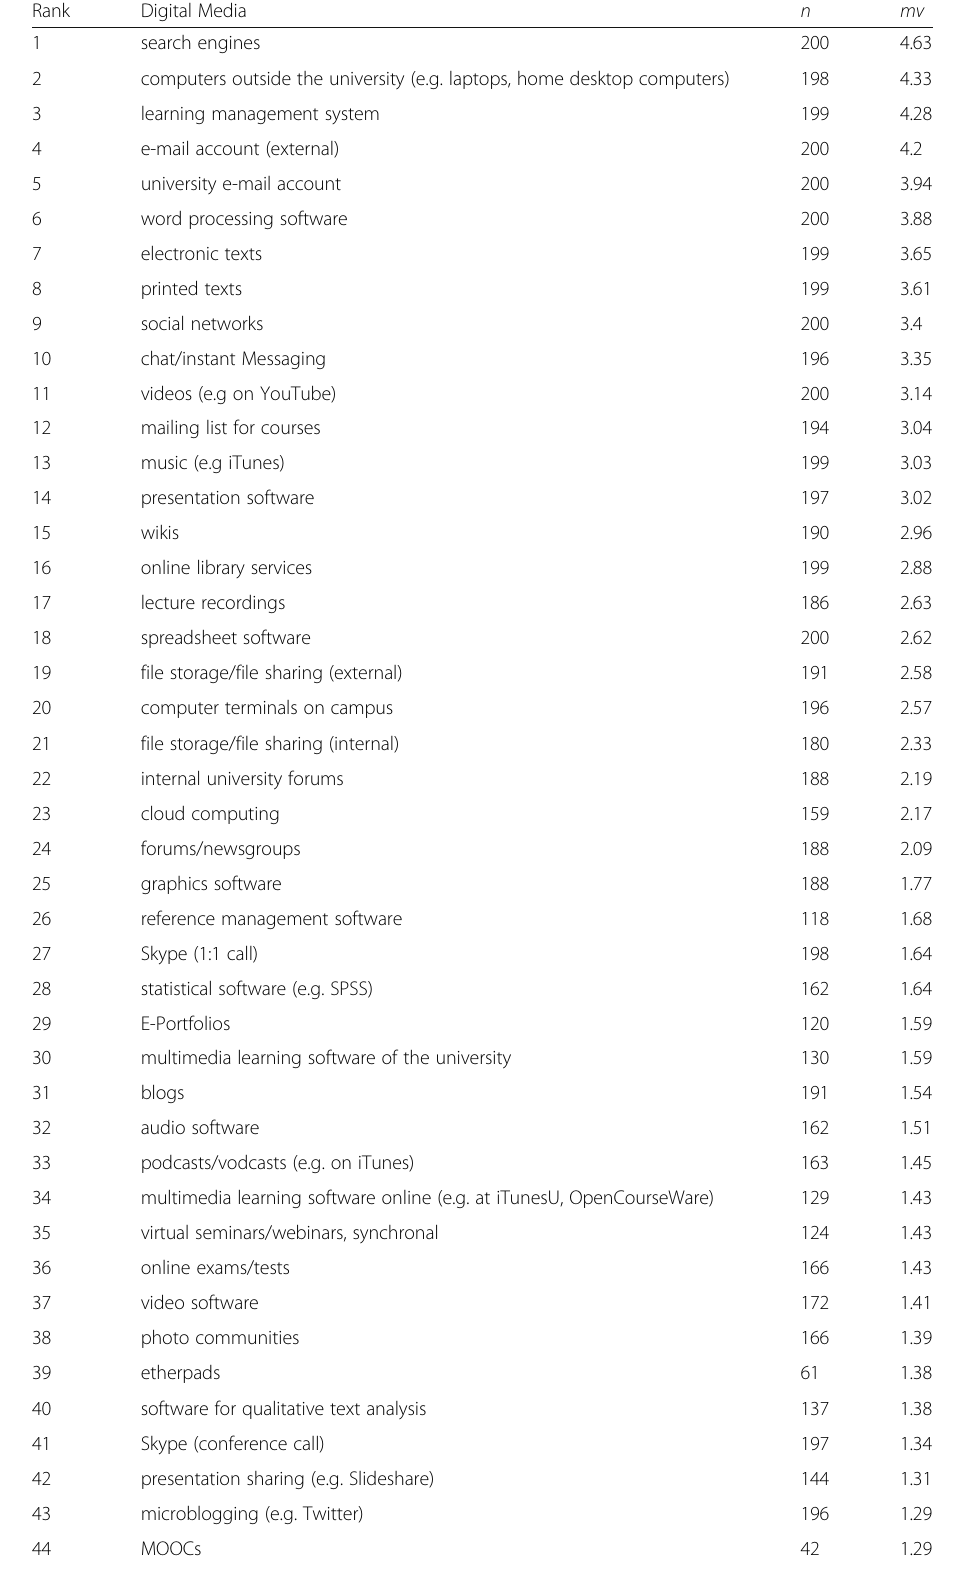
Table 3 Ranking by mean - ‘ How often do you use these digital media tools for studying?